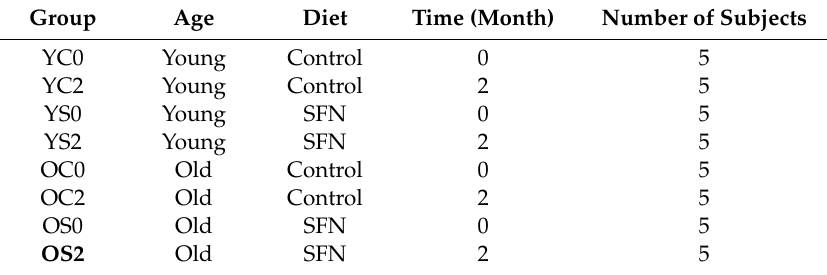
Table 1. Experimental design and study